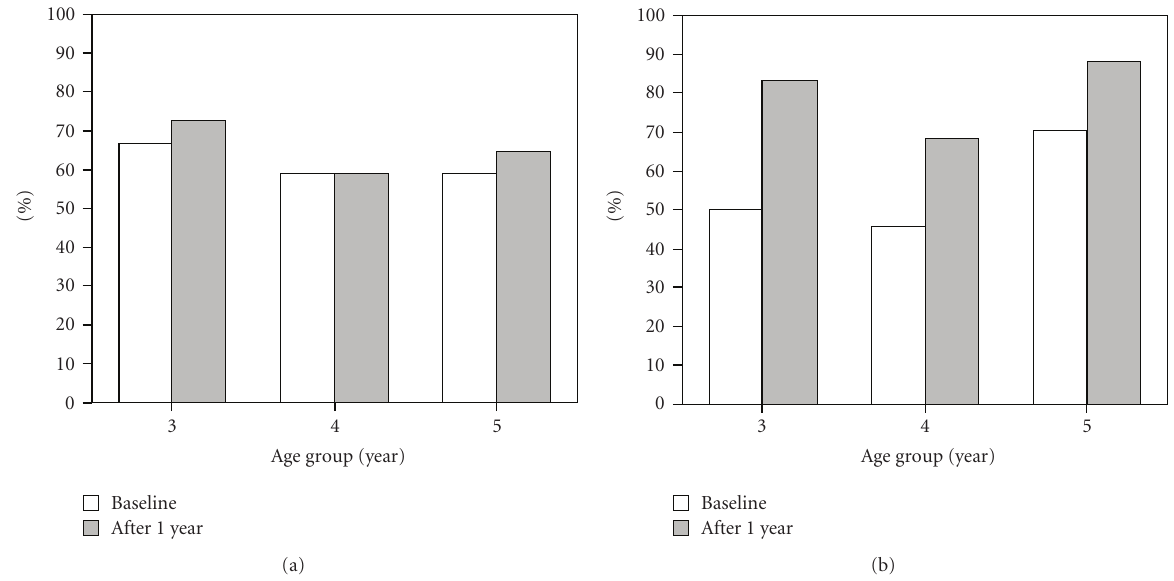
Figure 1: Distribution of S. mutans (a) and S. sobrinus (b) in di ff erent age groups at the baseline and after 1 year.